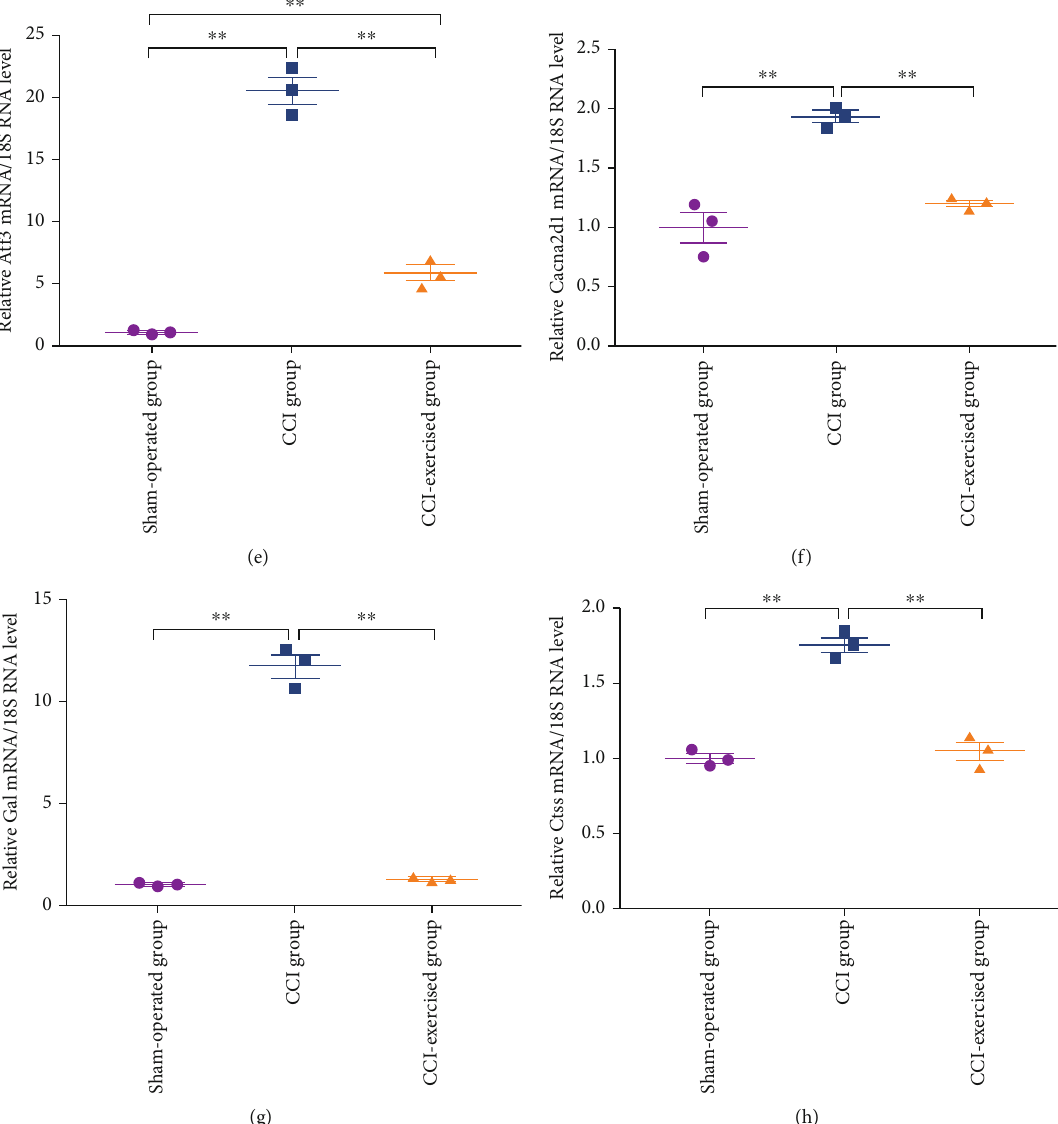
Figure 9: Validation of DEGs by quantitative real-time PCR (qRT-PCR). mRNA expression levels of (a) mir-145-5p, (b) mir-341, (c) mir- 300-5p, (d) mir-653-5p, (e) Atf3, (f) Cacna2d1, (g) Gal, and (h) Ctss in the L4 – L6 DRG at 28 days after surgery. Analyses of data were done by one-way ANOVA, followed by Tukey ’ s multiple comparison test. Values indicate the mean ± standard errorof mean ; n = 3 animals/group. ∗ denotes p < 0 : 05 ; ∗∗ denotes p < 0 : 01